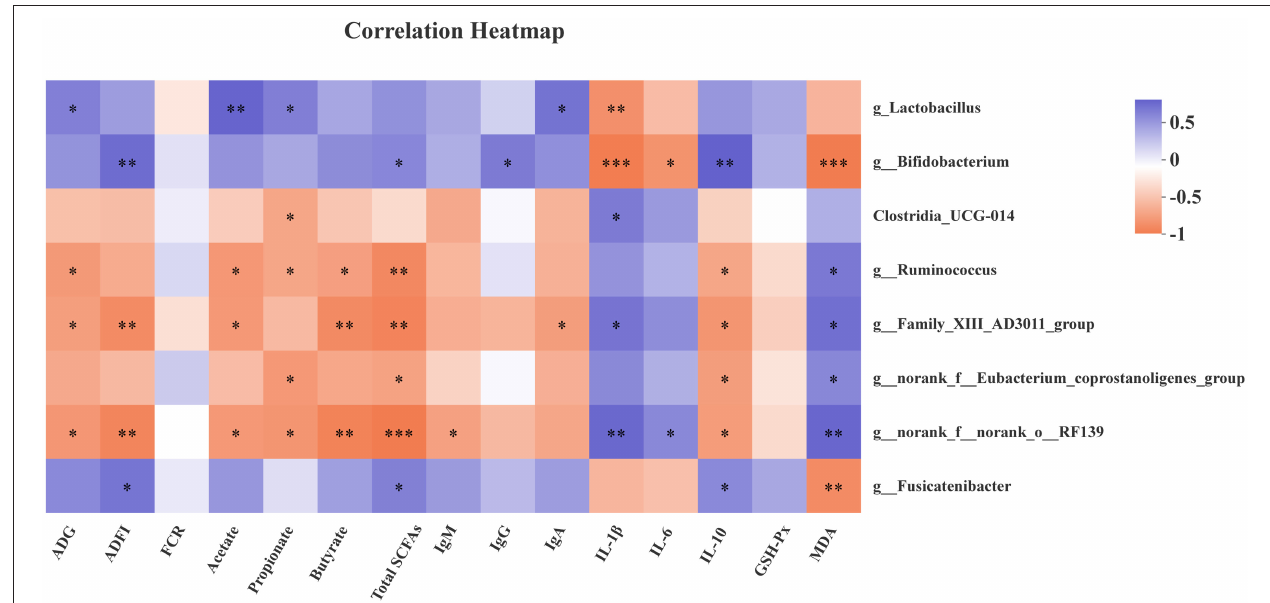
FIGURE 3 | Correlation heatmap between microbiota and antioxidant capability, immune function, growth performance, and fecal SCFAs. Spearman correlations were applied. ADG, average daily gain; ADFI, average daily feed intake; FCR, feed conversion rate; Total SCFAs, total short-chain fatty acids; GSH-Px, glutathione peroxidase; MDA, malondialdehyde. Total SCFAs = acetate + propionate + butyrate. * P < 0.05, ** P < 0.01, and *** P <